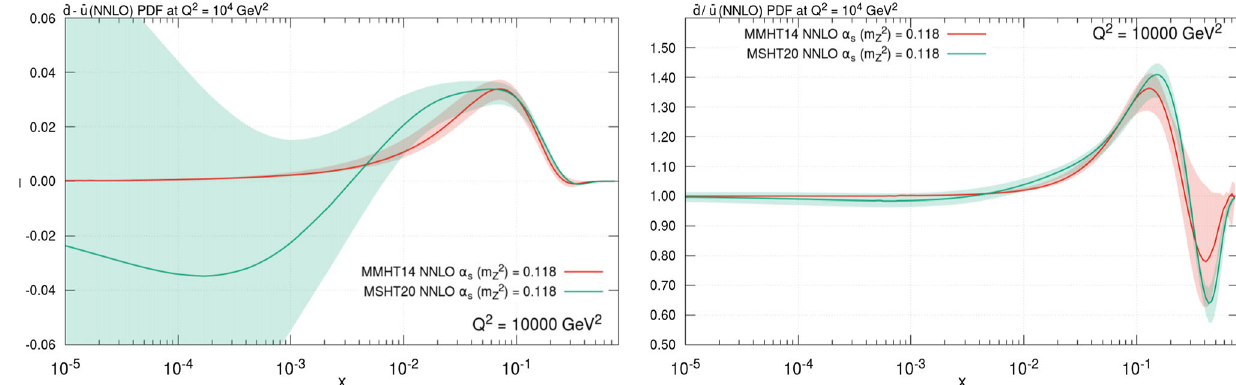
Fig. 25 (Left) ¯ d − ¯ u and (right) ¯ d / ¯ u PDFs, for MSHT20 and MMHT14 at NNLO and Q 2 = 10 4 GeV 2 . In MMHT14 the input PDFs parameterised ¯ d − ¯ u , whereas now in MSHT20 we parametrise ¯ d / ¯ u